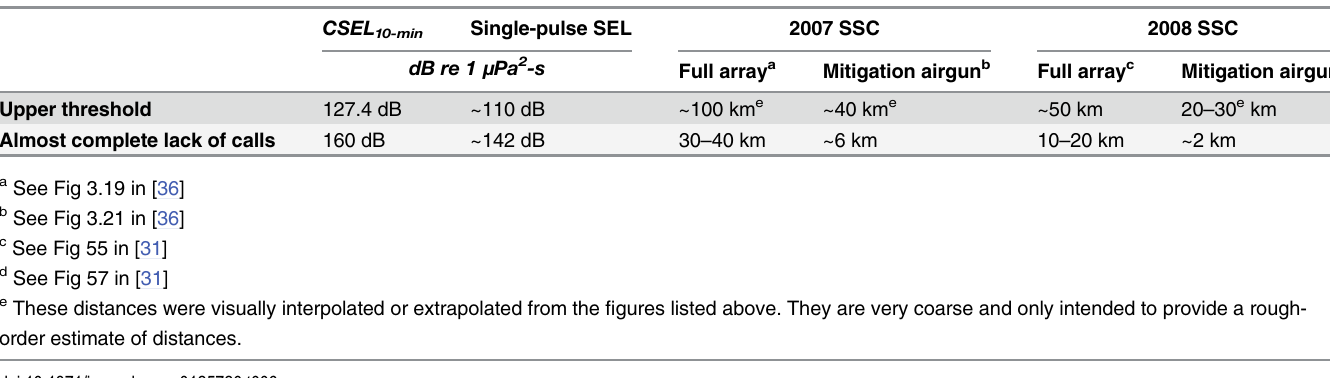
These distances were visually interpolated or extrapolated from the fi gures listed above. They are very coarse and only intended to provide a rough- order estimate of